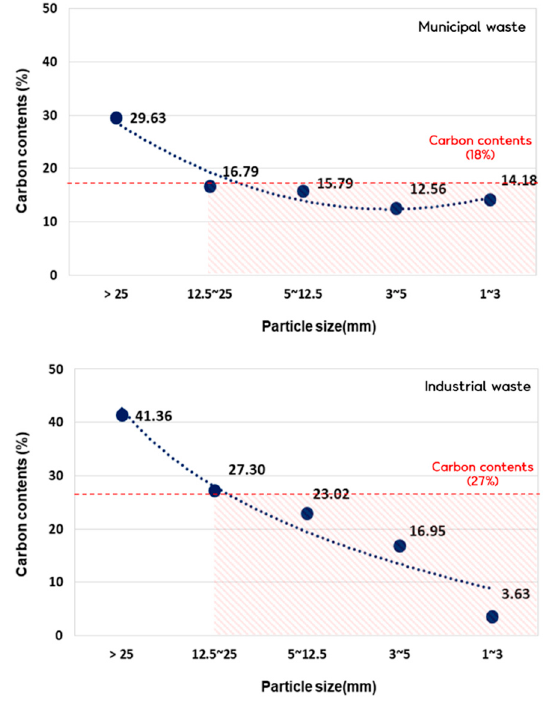
Figure 6. Carbon contents by particle size of residues.